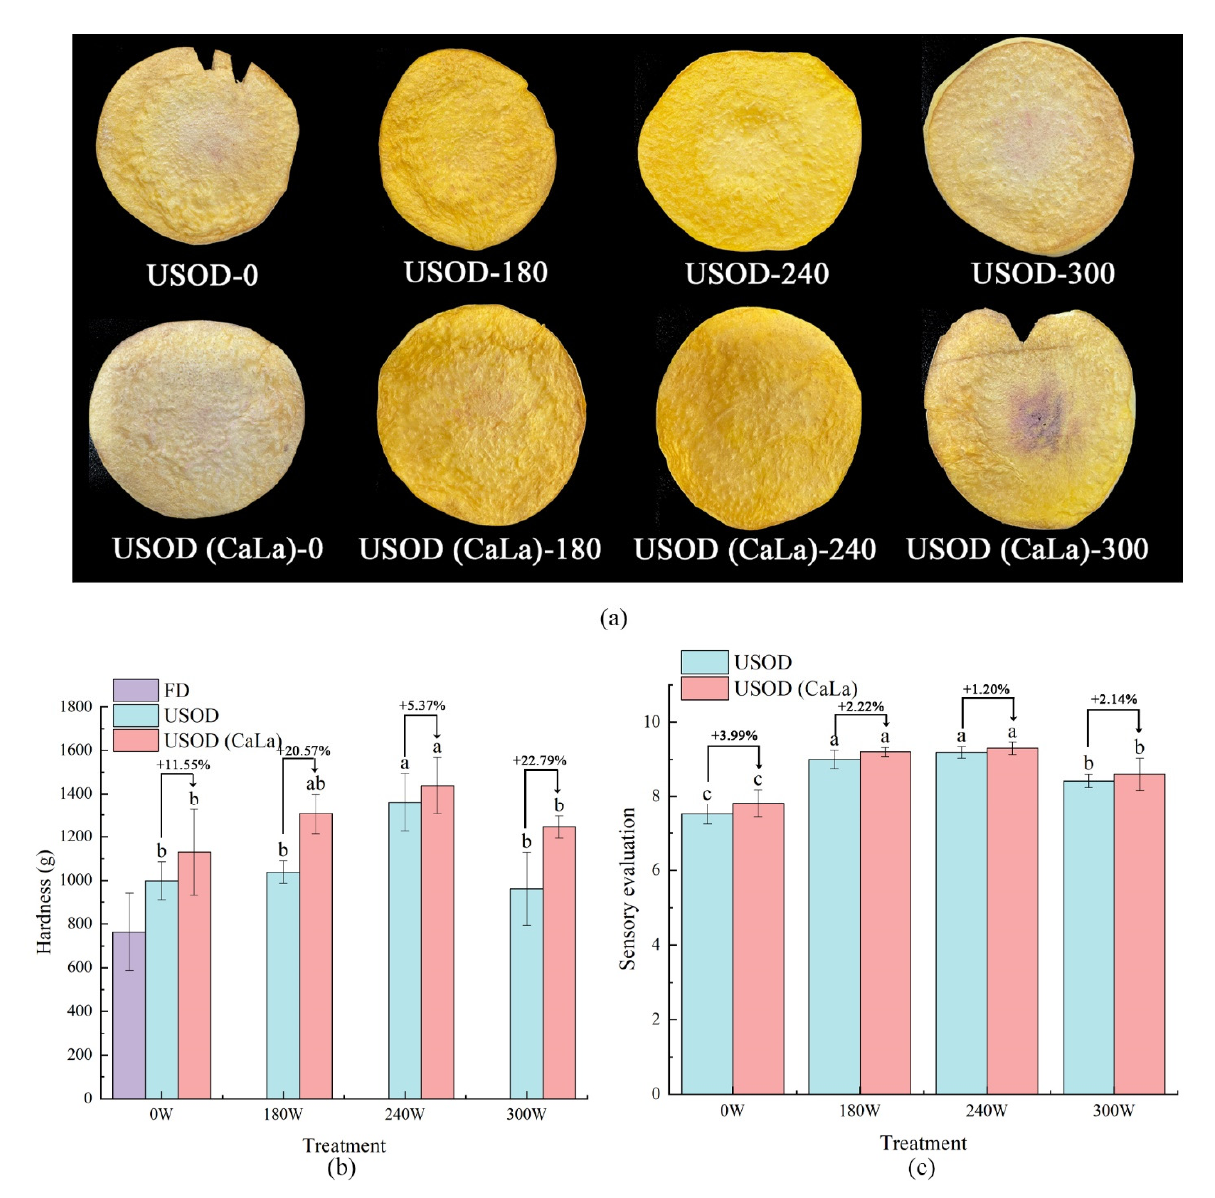
Figure 4. Samples ( a ), hardness ( b ) and sensory evaluation ( c ) of freeze-dried yellow peach slices with different treatments. The means between different ultrasonic power levels on the same conditions are indicated by different lowercase letters.